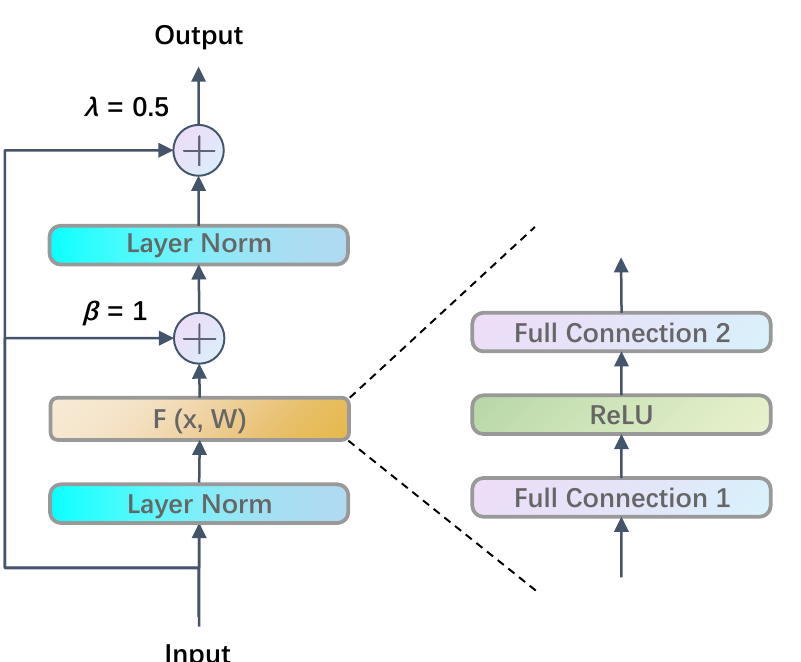
Figure 6. Full connected double skip connection in Transformer.